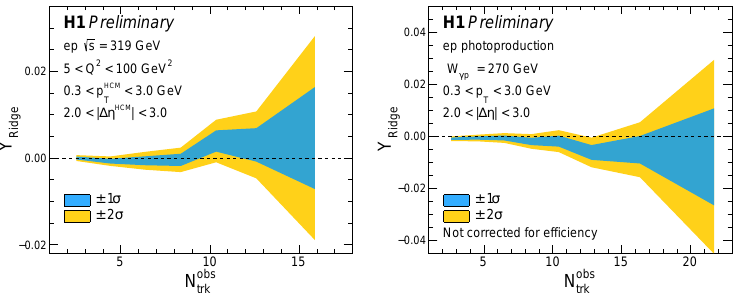
Figure 2: 2PCs in ep DIS collisions at < 20 multiplicity regions from left to right. 15 ≤ N obs trk